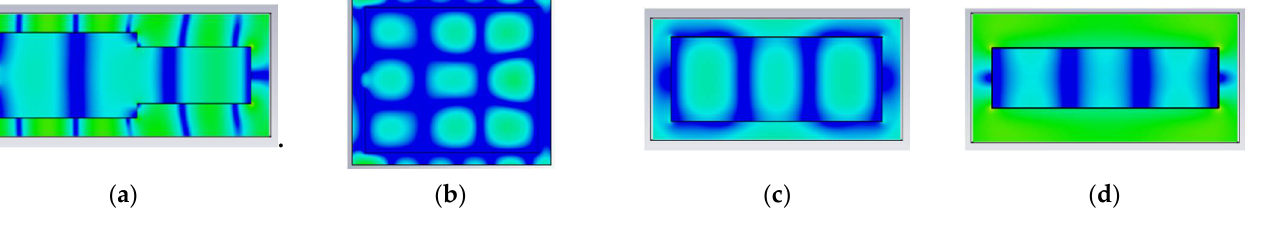
Figure 8. Mode303 Field Distribution of Capacitive Step. ( a ) x section, ( b ) y section, ( c ) z section of the front part, and ( d ) z section of the back part.